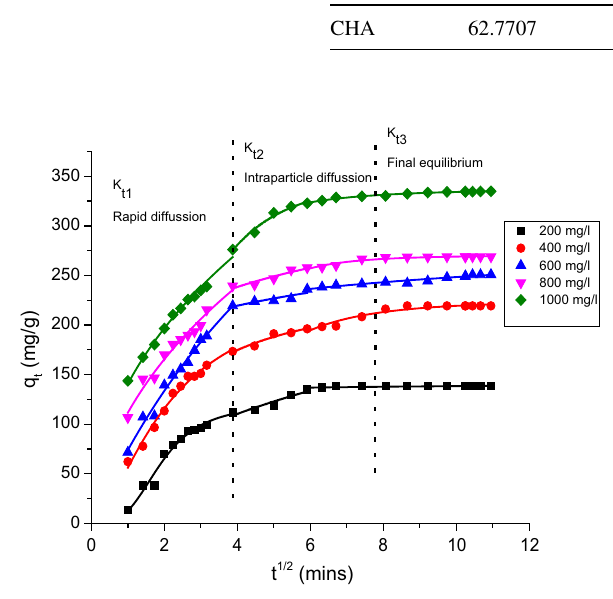
Fig. 10 Plot of intraparticle diffusion model for Rh-B dye adsorption onto CHA